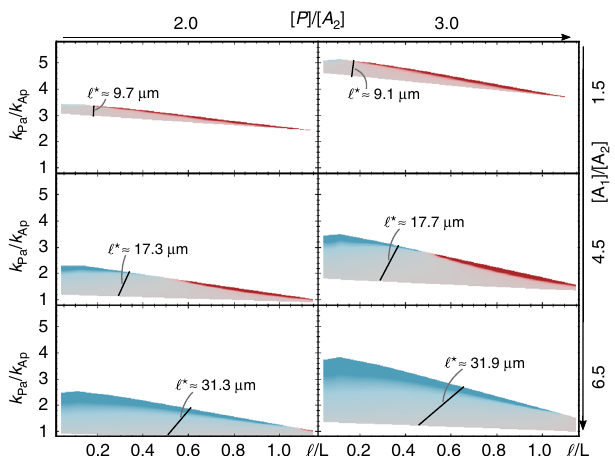
Fig. 5 Relative protein numbers determine robustness of cell polarity. Linear stability analysis for a range of density ratios [ P ]/[ A 2 ] and [ A 1 ]/[ A 2 ]; [ A 2 ] was kept constant. Each graph shows the range of phosphorylation ratios ( k Pa / k Ap ) and relative reactivation lengths ( ℓ ∕ L) where the base state is linearly unstable, with δσ given by the same colour code as in Fig. 4a; fi xed parameters are k Ap = 0.4 μ m s − 1 and D cy = 30 μ m 2 s − 1 , and further parameters not varied can be found in Table 1. FEM parameter sweeps of k Pa and λ , with fi xed parameters k Ap = 0.4 μ m s − 1 and D cyt = 30 μ m 2 s − 1 , for each density set show that the steady-state polarisation axis also depends strongly on the ratio [ A 1 ]/[ A 2 ]. The steady state switches from short- to long-axis polarisation at the black line in each graph, indicating ℓ ⋆